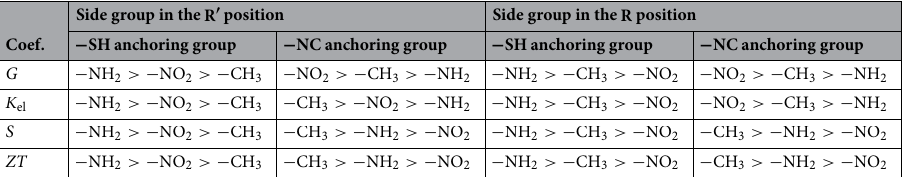
Table 1. Comparative results for thermoelectric properties of the anthracene molecular junction with amine ( − NH 2 ), nitro ( − NO 2 ) or methyl ( − CH 3 ) as the side group in the R ′ and R positions mediated by thiol ( − SH ) or isocyanide ( − NC ) as the anchoring group in the X position evaluated at T = 300 K .